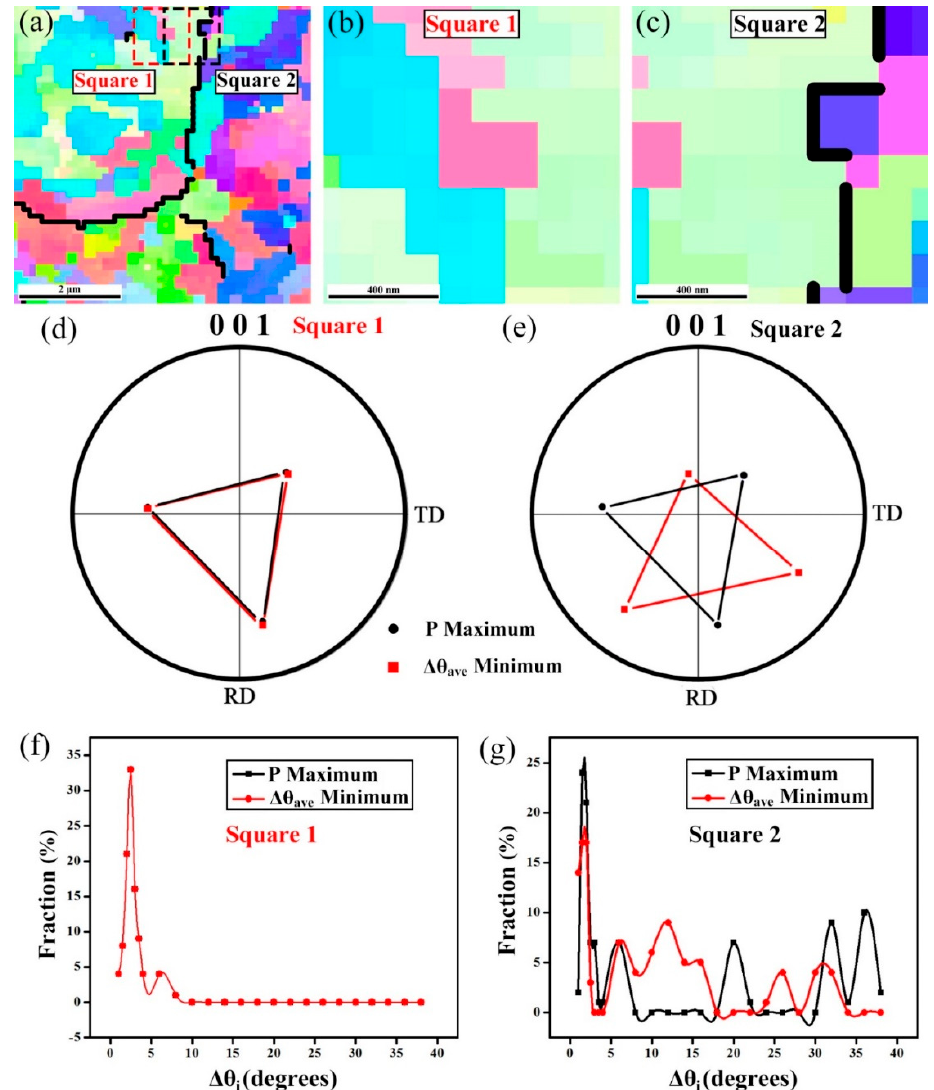
Figure 6. ( a ) Enlarged IPF map of the dashed box in 5(a). IPF maps of cropped Squares 1 ( b ) and 2 ( c ). ( d ) 001 pole figure of the γ orientations determined by two different criteria for Square 1 ( d ) and Square 2 ( e ). Distribution of ∆ θ i of the determined γ orientations by two different criteria for Square 1 ( f ) and Square 2 ( g ).